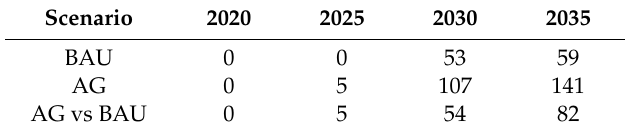
Figure 2. Power generation profiles of China’s electricity market part in a non-typical day during the planning horizon under two demand response scenarios: ( a ) The BAU demand response scenario; and ( b ) the AG demand response scenario. Table 11. BIGM annual operating hours under two demand response scenarios. Table 11. BIGM annual operating hours under two demand response scenarios.